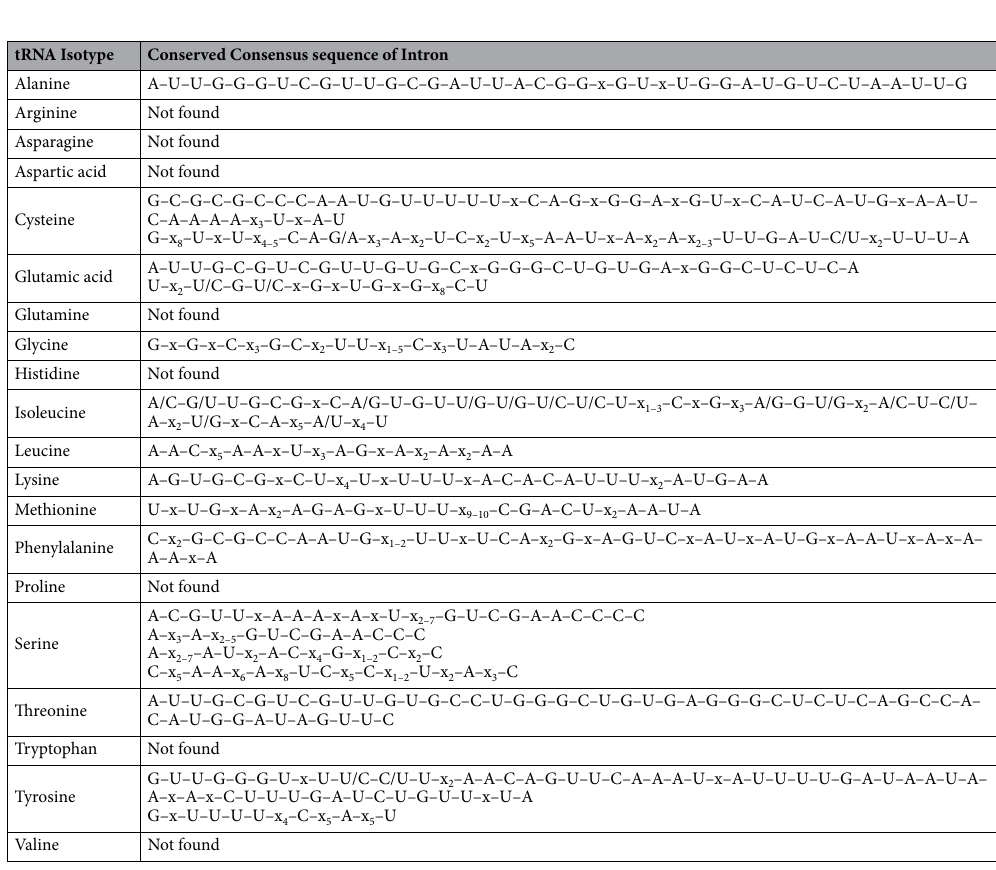
Table 2. Conservation of introns in chloroplast tRNAs. From the mentioned tRNA isotypes, at least eight isotypes do not encode any intron in their tRNA genes or its not